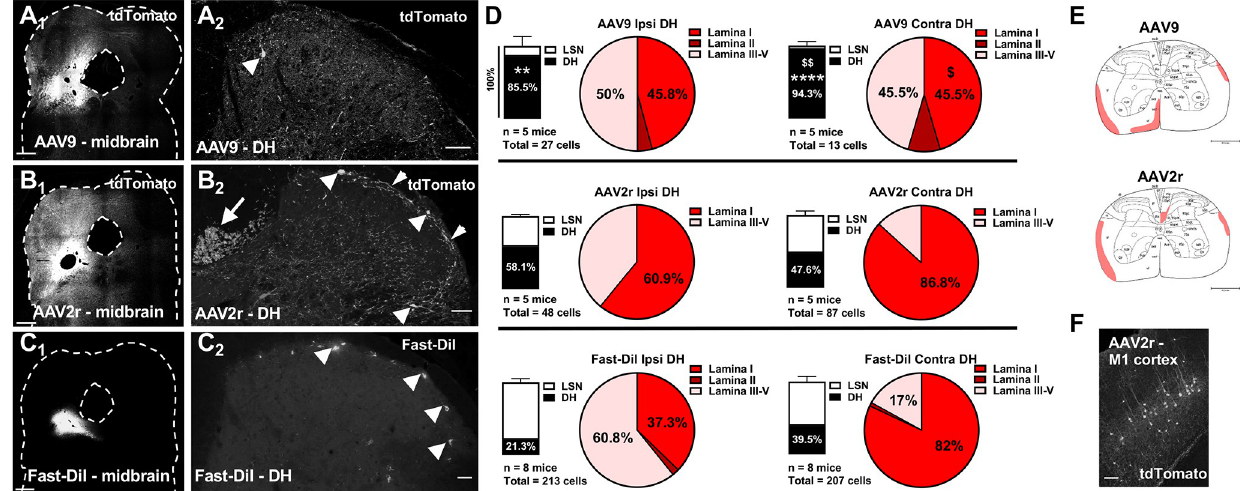
Fig 1. Targeting of spinoparabrachial neurons by AAV9, AAV2retro, and DiI. A-C, Representative images of the parabrachial complex (A1, B1, C1; scale bars = 500 μ m) and dorsal spinal cord (A2, B2, C2; scale bars = 50 μ m) following parabrachial complex injections of AAV9 (A), AAV2retro (AAV2r, B), or Fast-DiI (C). The images in B2 and C2 represent a maximum intensity projection of 3D stacks spanning 12 and 16 μ m, respectively, and collected with a 4- μ m z-step. Arrowheads in A2, B2 and C2 highlight labeled spinal projection neurons in the superficial dorsal horn. Additionally, in B2, the short arrow highlights a plexus of labeled processes in lamina I, and the long arrow indicates labeling of the dorsal corticospinal tract. D, Stacked Bars represent the relative distribution of labeled projection neurons between the dorsal horn (DH) and the lateral spinal nucleus (LSN) in the ipsilateral (left) and contralateral (right) spinal cord following injection with AAV9 (top), AAV2retro (middle), or Fast-DiI (bottom) ( �� p < 0.01, ���� p < 0.0001, compared to Fast-DiI; $$ p < 0.01, compared to AAV2r). The total number of labeled neurons analyzed and the number of animals (n) is noted under the stacked bars. Pie charts in D show the percentage of labeled neurons present in lamina I-V of DH. Proportions of labeled neurons in spinal laminae were compared using Two-way ANOVA and Bonferroni posttest ($, p < 0.05 compared to AAV2r). E, The average labeling of spinal tracts at the level of L3 is shaded for AAV9 (E1) and AAV2r (E2). F, Retrograde labeling of cortical neurons in primary motor cortex (M1) following parabrachial injection of AAV2retro; scale bar = 150 μ